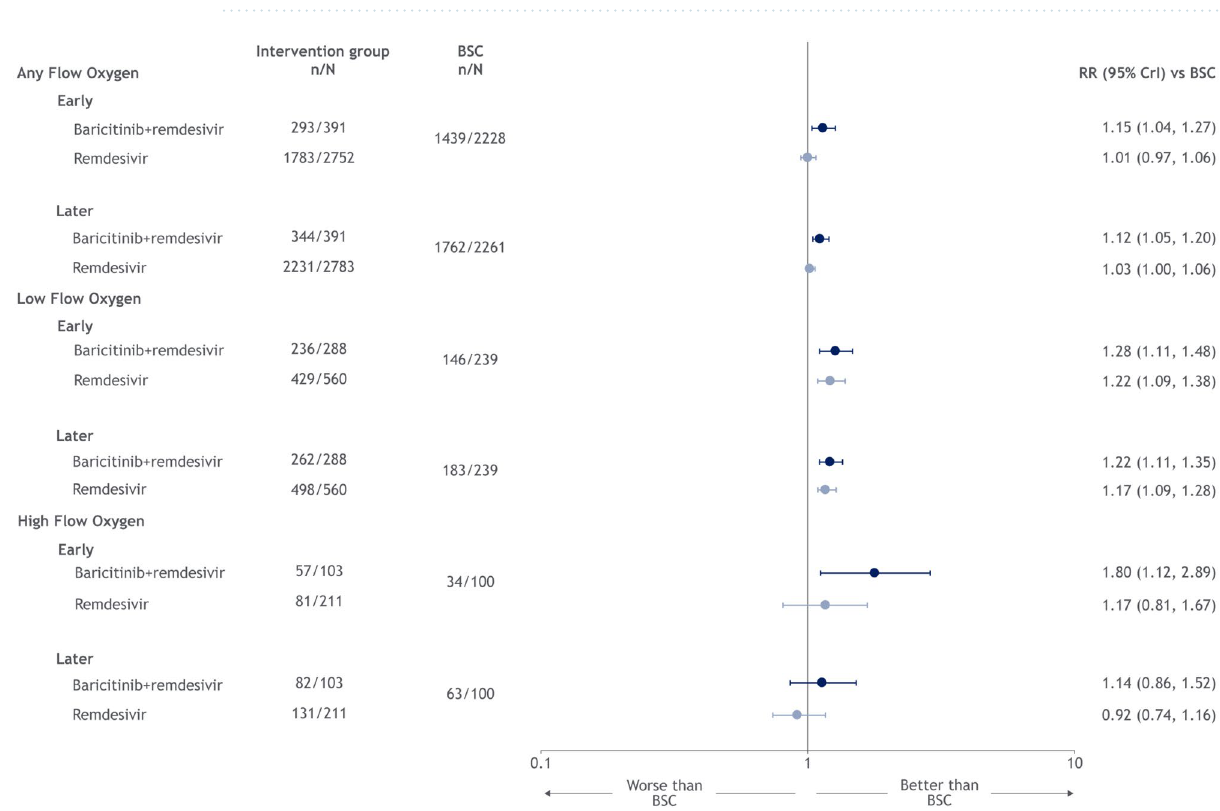
Figure 3. Forest plot for recovery endpoint, by type of non-invasive oxygen